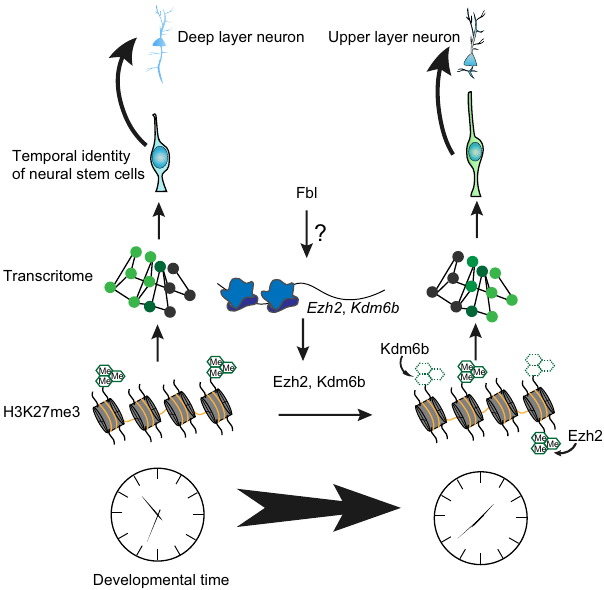
Fig. 9 Fbl drives the developmental clock of neural stem cells (NSCs). Fbl enhances the translation of Ezh2 and Kdm6b. Ezh2 and Kdm6b change H3K27me3 pattern in NSCs. H3K27me3 patterning further affects gene expression change and regulates the temporal fate of NSCs. However, it is still unknown how Fbl affects the translation of Ezh2 and